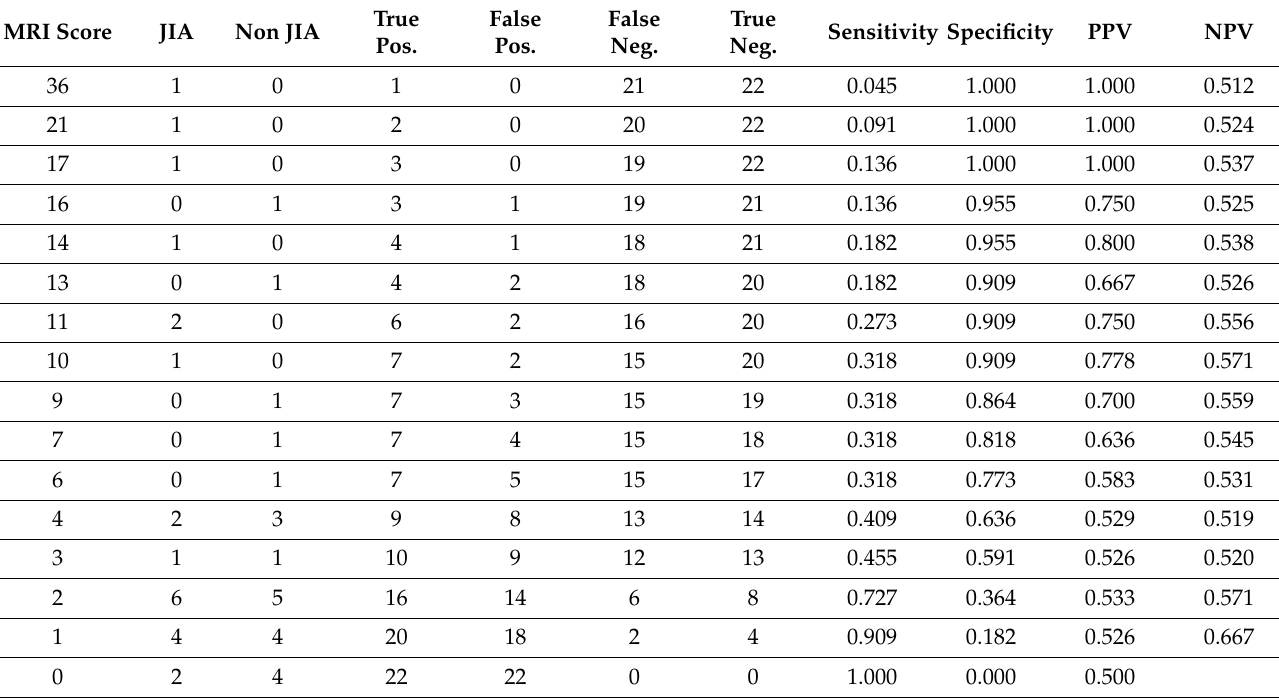
Table 4. Diagnostic value of the summarized MRI score as a predictor of